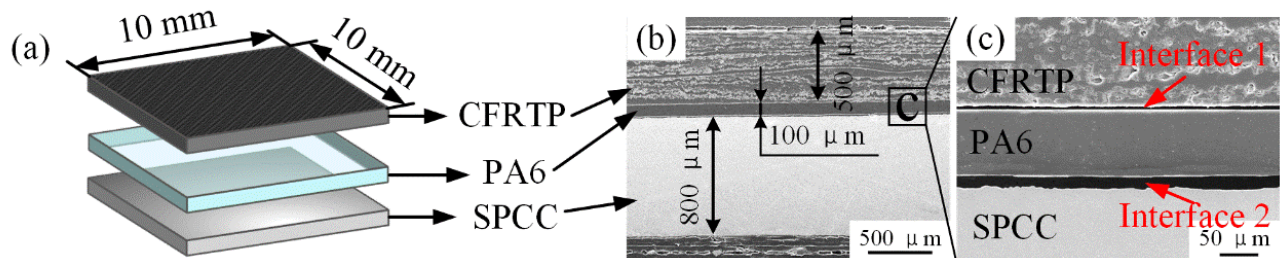
Figure 3. Joint structure composition: ( a ) schematic diagram of the joint composition (not in scale); ( b ) cross-section of the joint before joining; ( c ) interface 1 and 2.